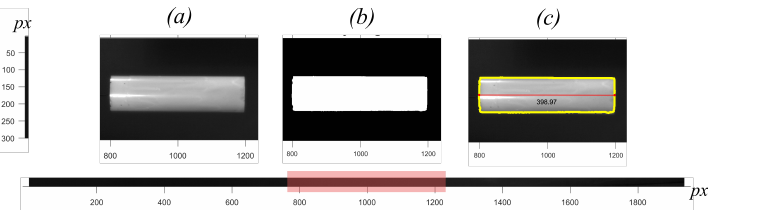
Figure 8. Measured length from image of falling cylindrical object taken from setup. ( a ) original image, ( b ) binary image, ( c ) Original image with boundaries and length ( L px ) .